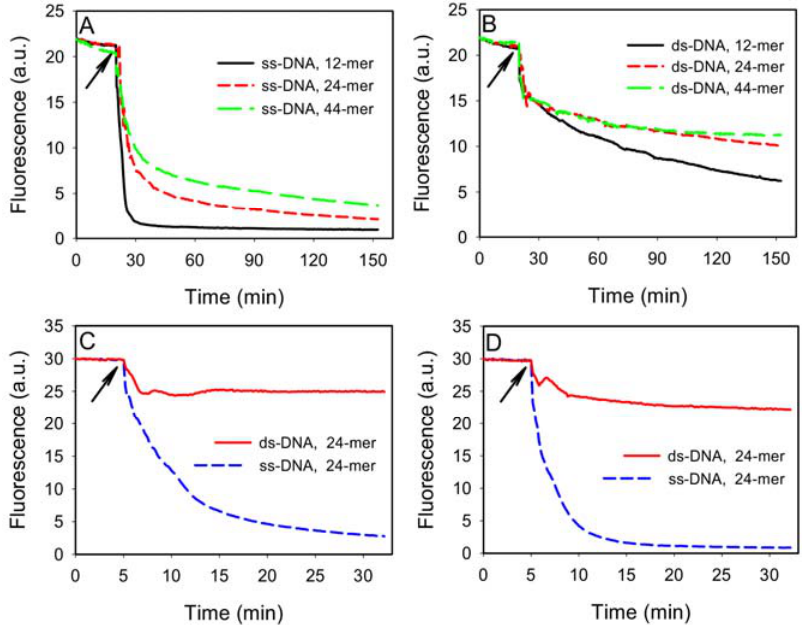
Figure 2. Kinetics of fluorescence change indicative of DNA adsorption by GO for ss-DNA ( A ) or ds-DNA ( B ) of different length. In ( B ), FAM-DNA:cDNA = 1:1.5. The buffer contained 100 mM NaCl, 25 mM HEPES, pH 7.6. Comparison of ss- and